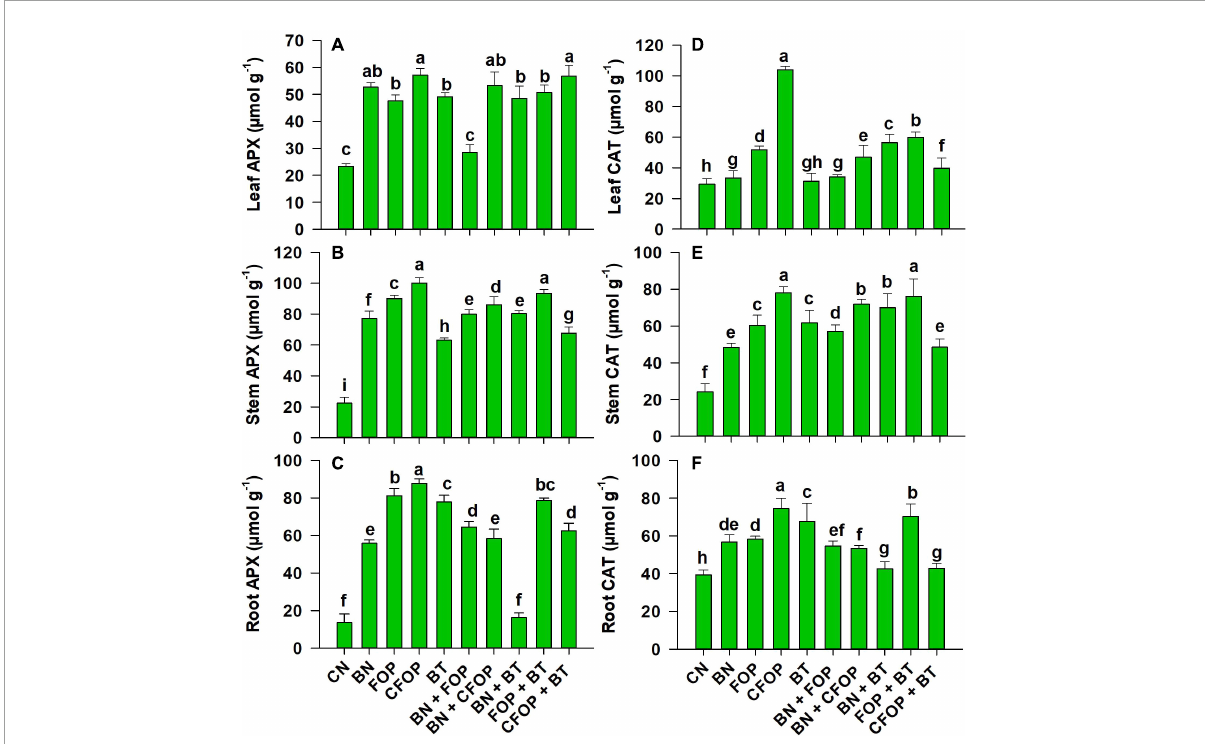
FIGURE6 Ascorbate peroxidase (APX) and catalase (CAT) concentrations in leaves (A,D) , stem (B,E) , and roots (C,F) of brinjal plant (Solanum melongena) as affected by various treatments: Control (CN); bentonite (BN); Iron Oxide nanoparticles (FOP); Cerium-doped iron oxide nanoparticles (CFOP); Azotobacter nigricans sp. (BT); BN + FOP; BN + CFOP; BN + BT; FOP + BT; T10 = CFOP + BT. At ( P < 0.05) column with changed letters are significantly